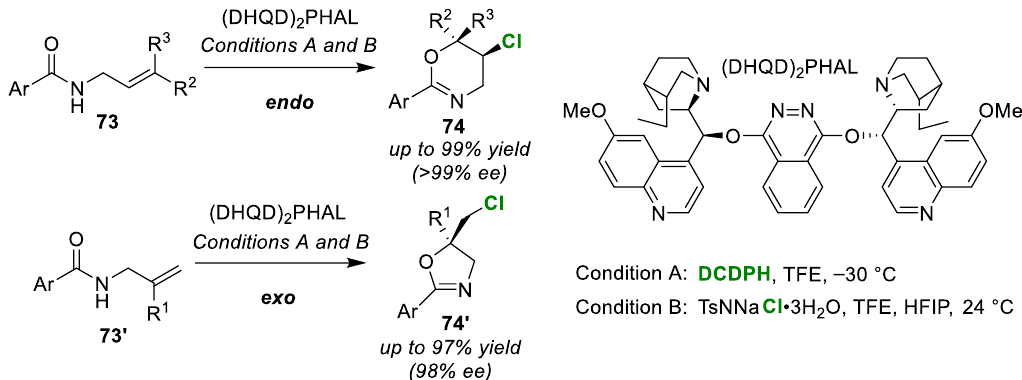
Figure 35. Selective syntheses of oxazines and oxazolines via the chloro-cyclization of olefinic amides ( 73 and 7 3′ ) using (DHQD) 2 PHAL. ( 73 and 73 (cid:48) ) using (DHQD) 2 PHAL.